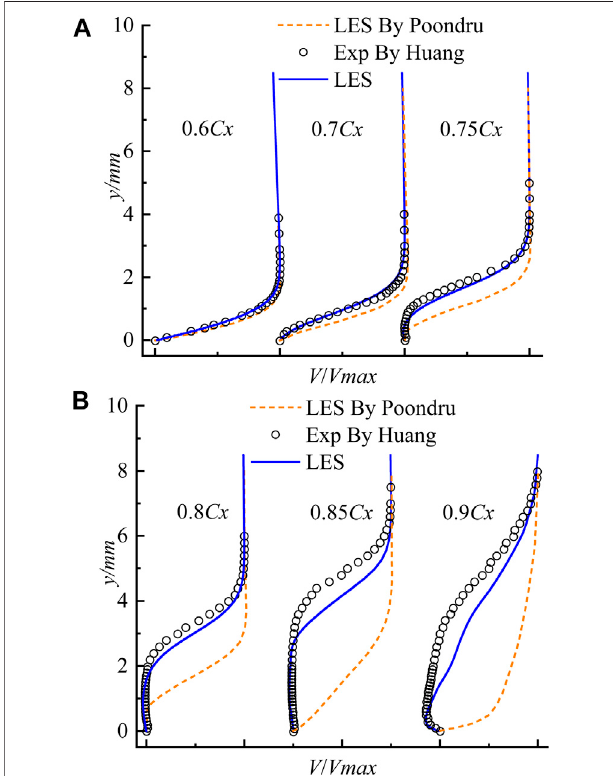
FIGURE 5 | Time-averaged (A) andspanwise-averaged (B) boundarylayer pro fi les compared with experimental data by Huang and LES data by